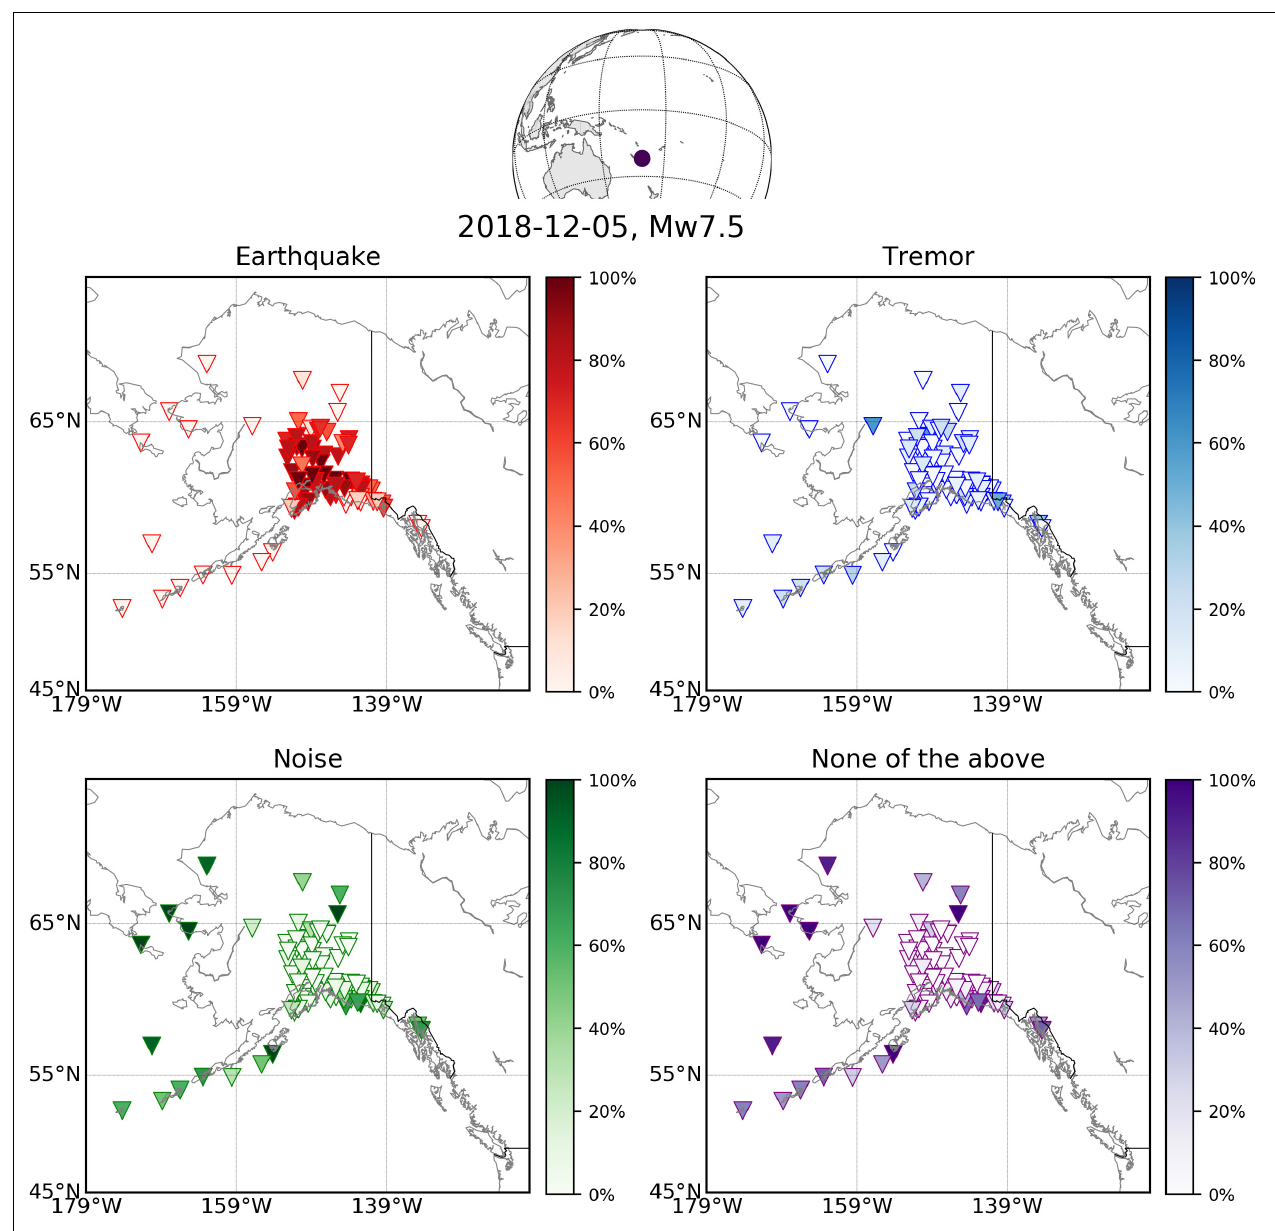
FIGURE 6 | Map of stations showing the location of recordings of triggered earthquake for different teleseismic earthquakes.